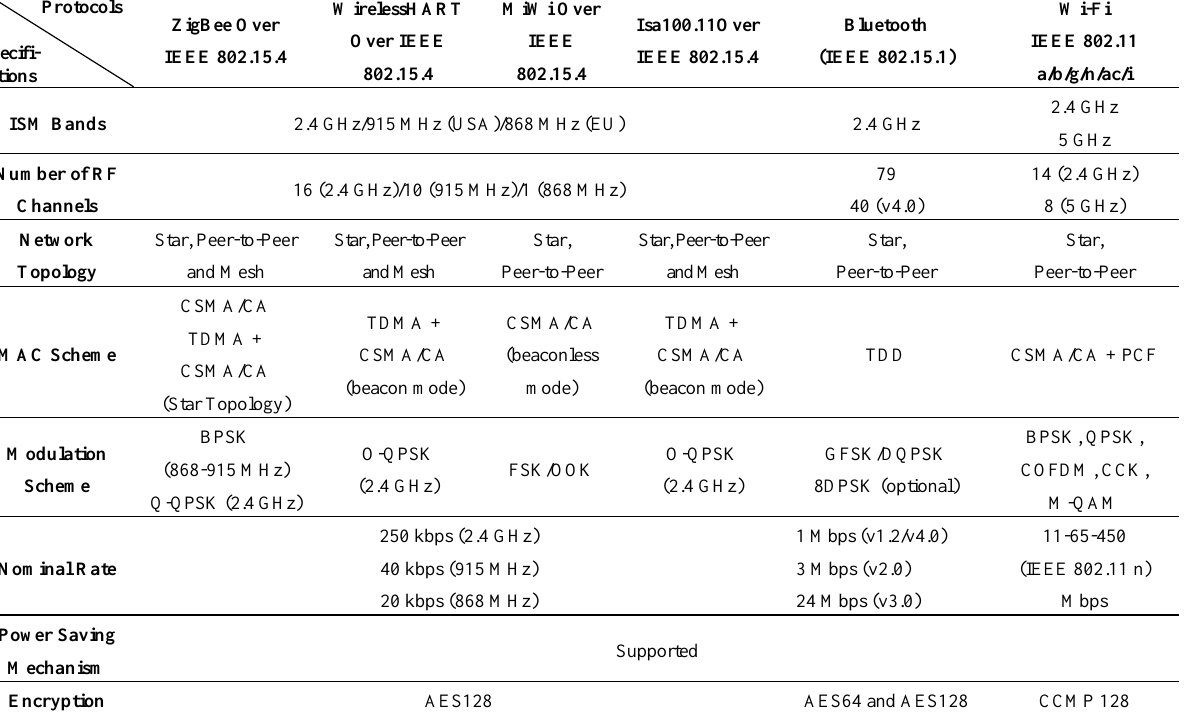
Table 1. Wireless Network Based on IEEE